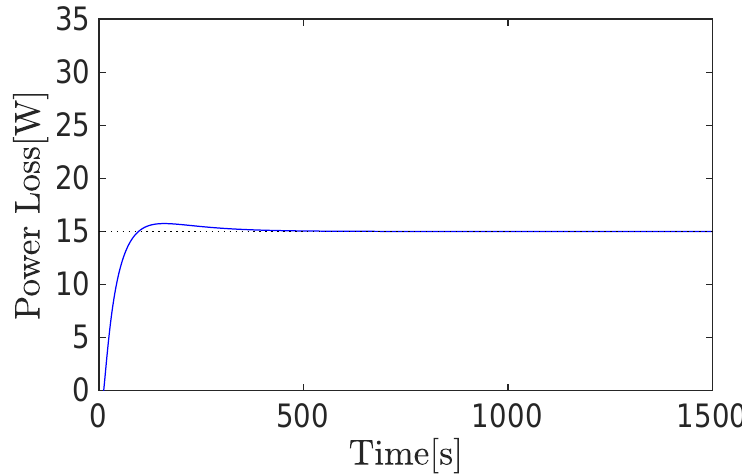
Figure 9. Time variation of thermal conductivity.